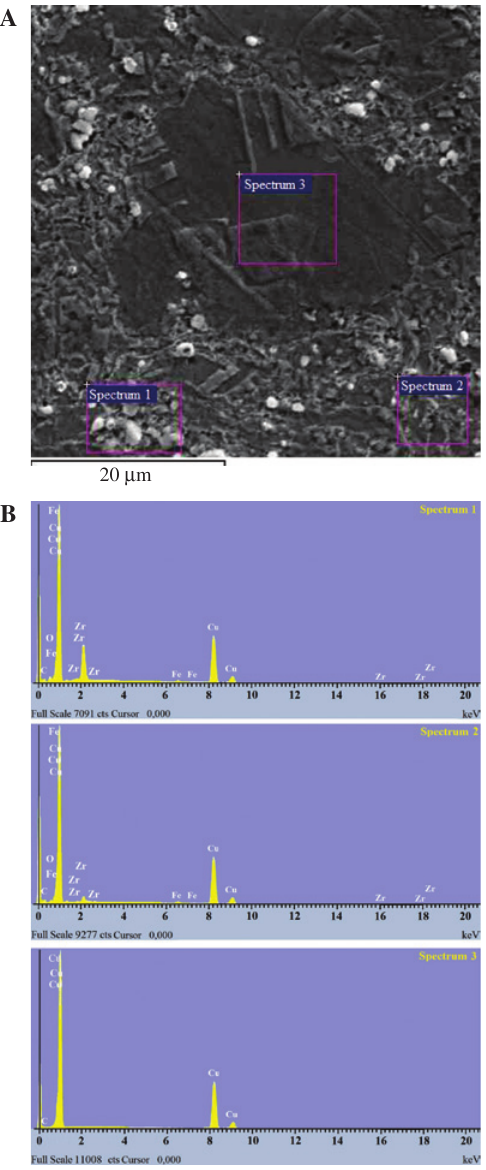
alloy compact after 30 h 2